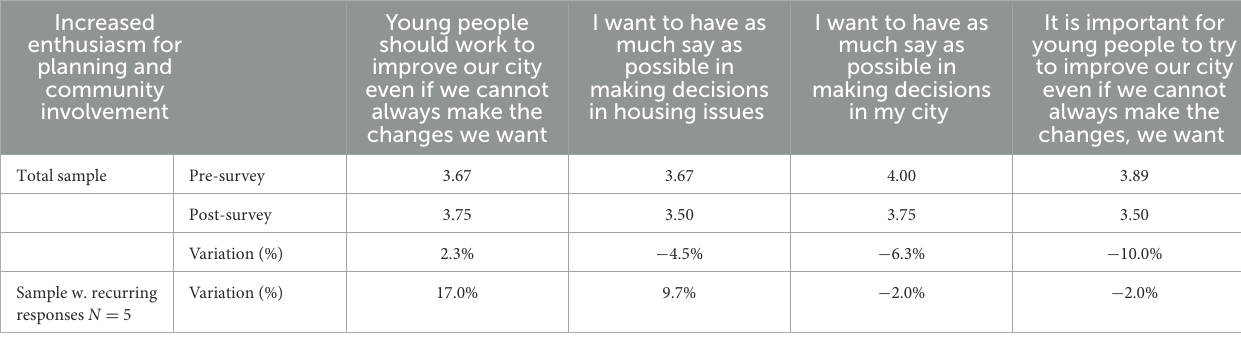
TABLE 5 How participating in UPLIFT affected the young individuals’ attitudes and behaviors (motivation to influence one’s community/for planning and community involvement). Increased enthusiasm